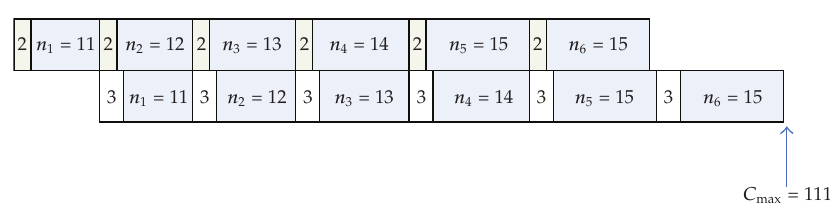
Figure 1: Optimal schedule of a 2-machine flowshop (cid:5) Example 3.2: n (cid:8) 80 ,s 1 < s 2 ,s 1 (cid:8) 2 ,s 2 (cid:8) 3 (cid:6)